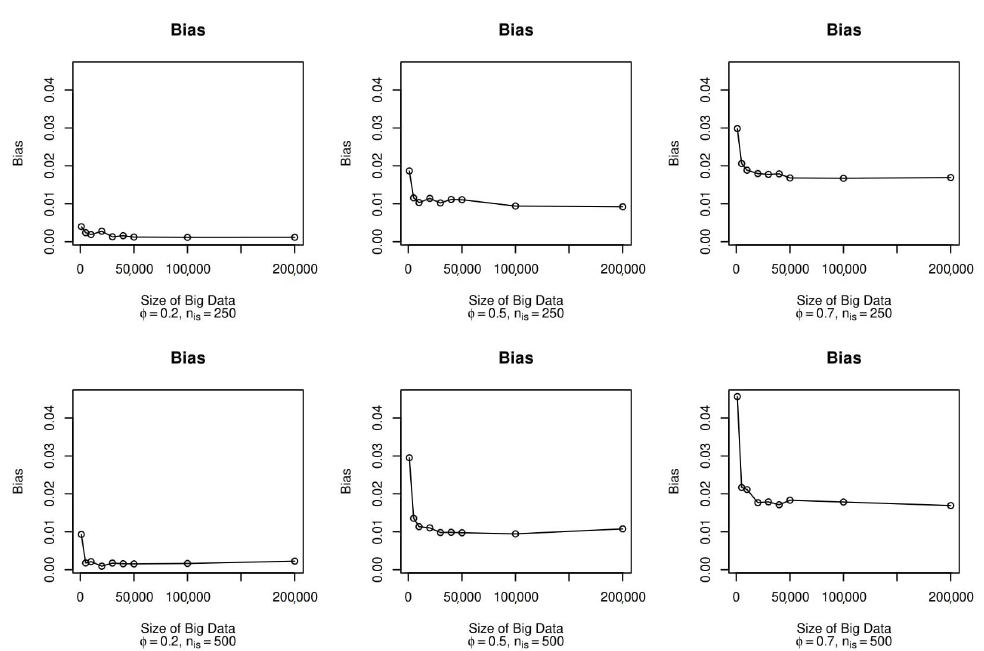
Figure 5. Bias for the proportion parameter according to the size of the big data, φ , and n is